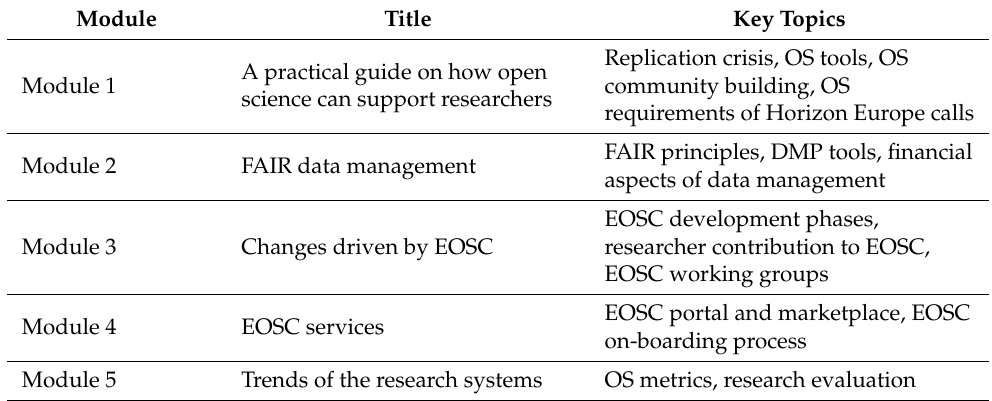
Table 2. Modules of the e-learning course ‘Open Science and EOSC in